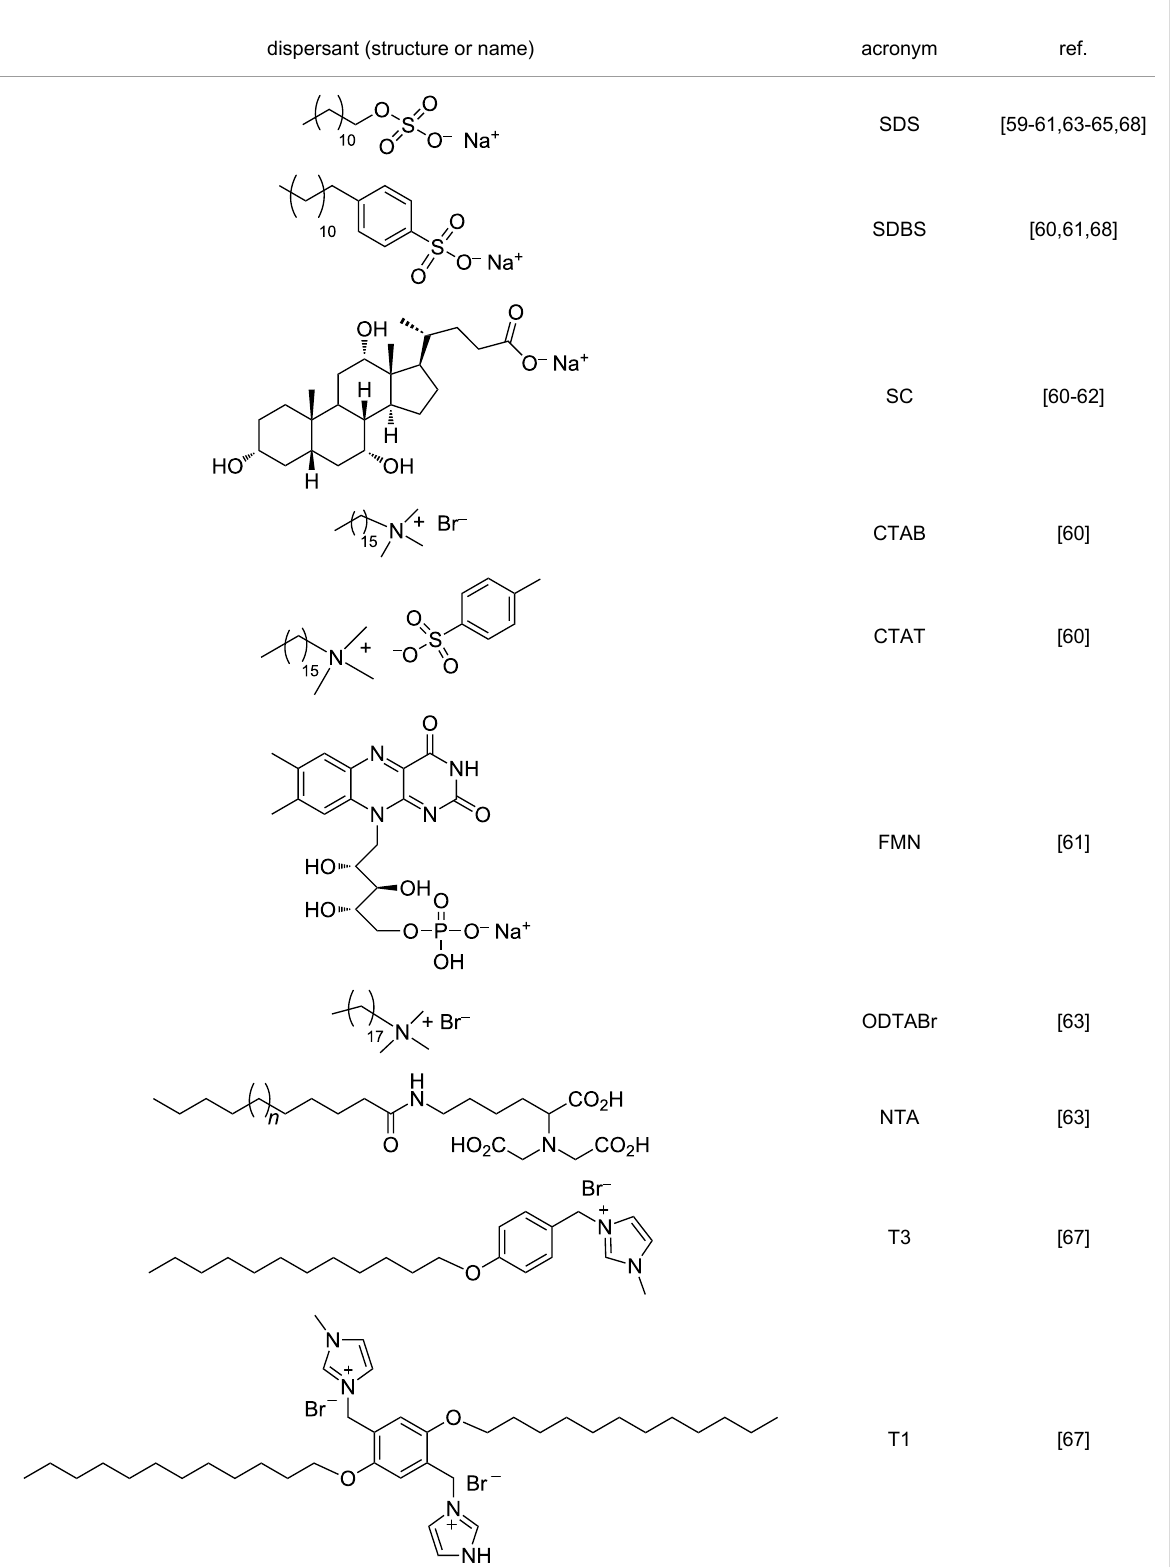
Table 2: Some amphiphilic molecules used for the dispersion of CNTs in